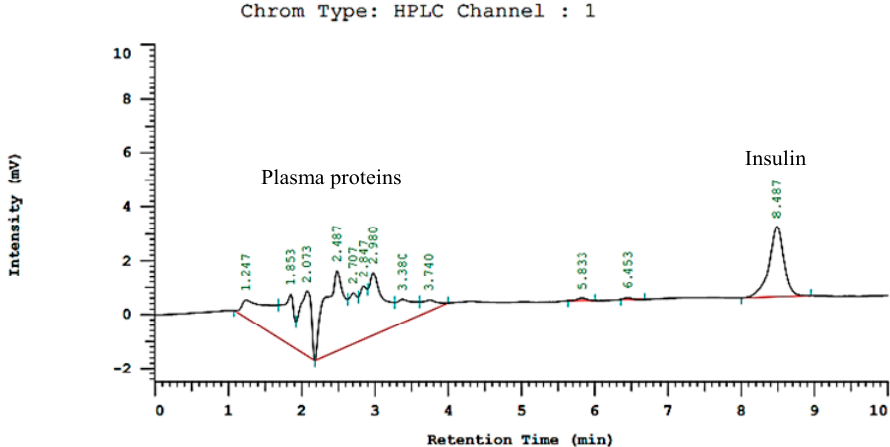
Figure 12. Chromatogram of plasma containing insulin (8.487 min retention time).